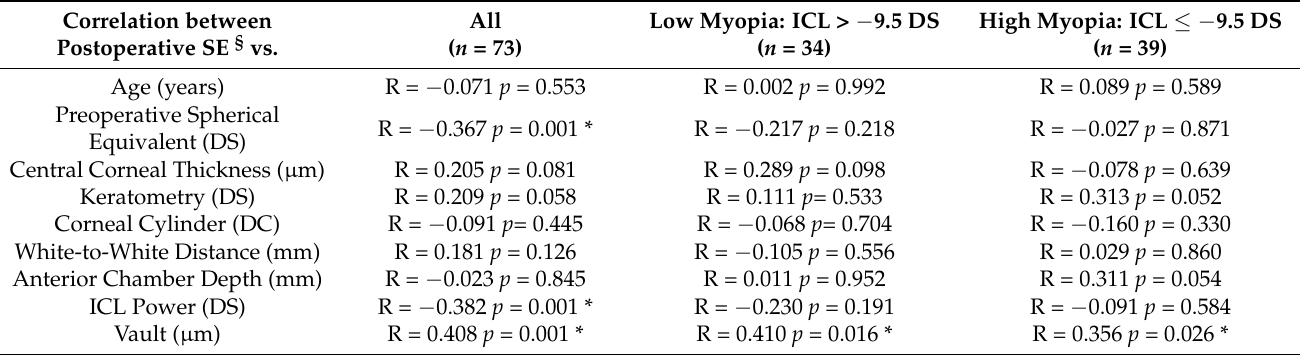
Figure 3. ( a ) Cumulative percentage of postoperative UCVA in logMAR. ( b ) Visual acuity variation from preoperative CDVA. Table 3. Bivariate correlation analysis between postoperative SE and demographic, refractive, anatomical, and ICL-related